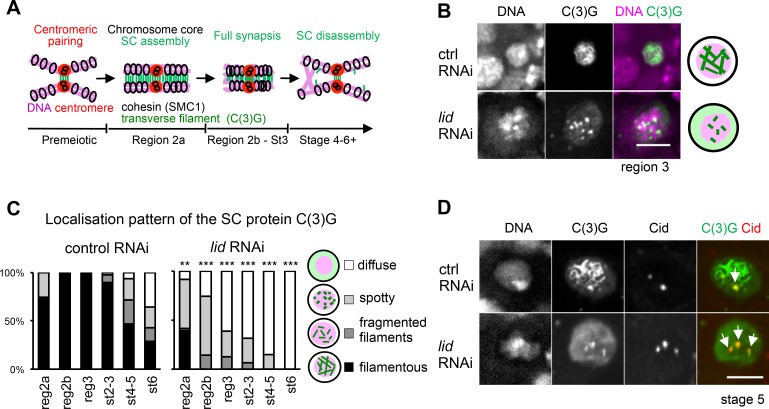
Loss of Kdm5/Lid leads to partial formation and instability of the SC along chromosome arms but does not affect persistence of a transverse protein at centromeres.(A) Schematic representation of early meiotic events. In region 2a, the SC starts to assemble to promote synapsis which results in crossover and chiasmata formation. The filamentous structure of the SC mostly disassembles by stage 6 of oogenesis except at centromeres. (B) A control region-3 oocyte with filamentous C(3)G staining, and a Kdm5/lid RNAi oocyte with spots of C(3)G staining. (C) Quantification of C(3)G staining pattern in control and Kdm5/lid RNAi oocytes. For region 2a, we classified each germarium based on the majority of the SC morphology in multiple nuclei which accumulate C(3)G. For region 2b where the two nuclei accumulate C(3)G, each germarium was scored for the morphology of the better formed SC. ** and *** indicate significant differences in the pattern distribution from control (p<0.01 and p<0.001, respectively). n≥14. (D) Centromeric C(3)G localisation in control and Kdm5/lid RNAi oocytes at stage 5. Cid, the Drosophila CenpA, highlights all centromeres. The arrows indicate colocalisation of the Cid signals with centromeric C(3)G. Colocalisation was observed in all oocytes examined (n = 27 for stage 4–6). Scale bars = 5 μm.